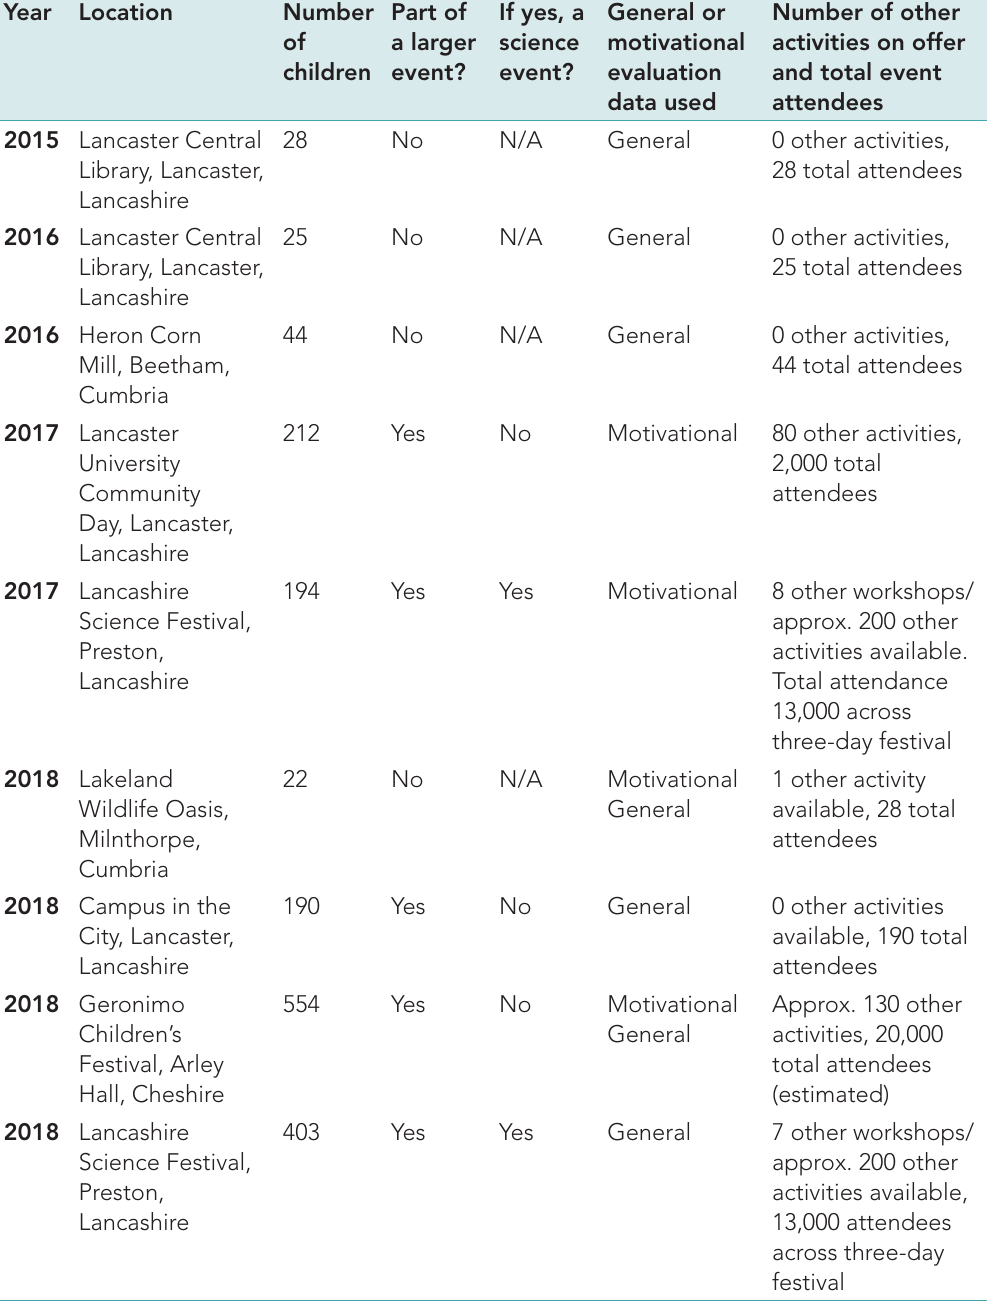
Table 1: Public events at which evaluation data used in this analysis were collected for Science